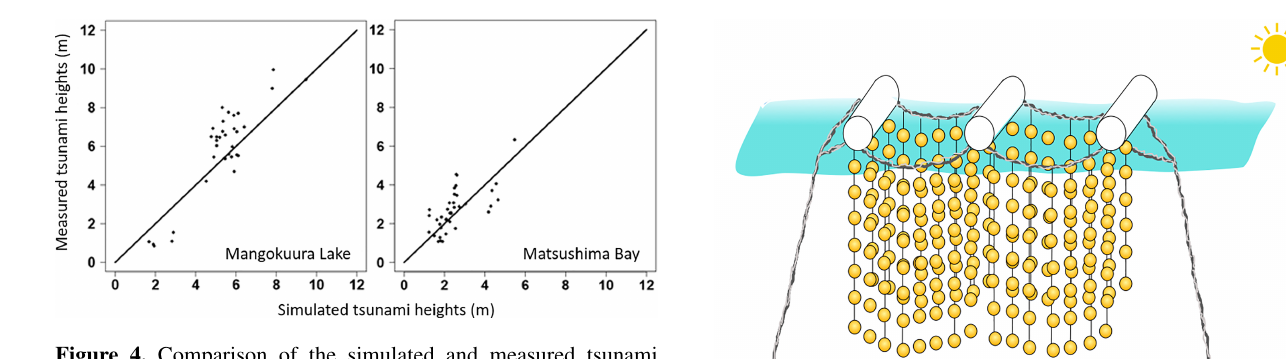
Figure 4. Comparison of the simulated and measured tsunami heights in Mangokuura Lake and Matsushima Bay.